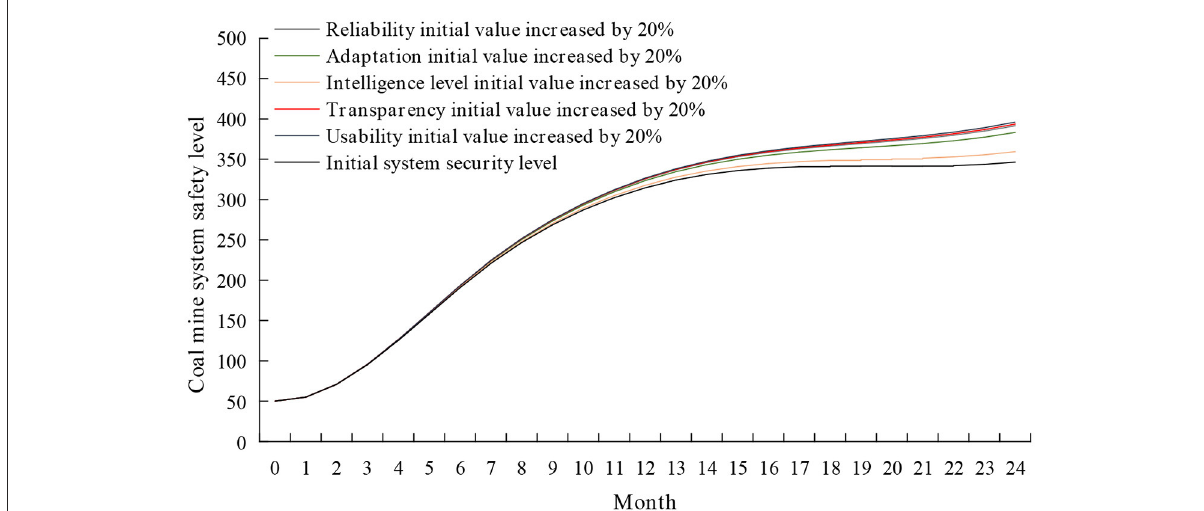
FIGURE11 Simulation results of coal mine system safety after the intervention of the intelligent system subsystem.